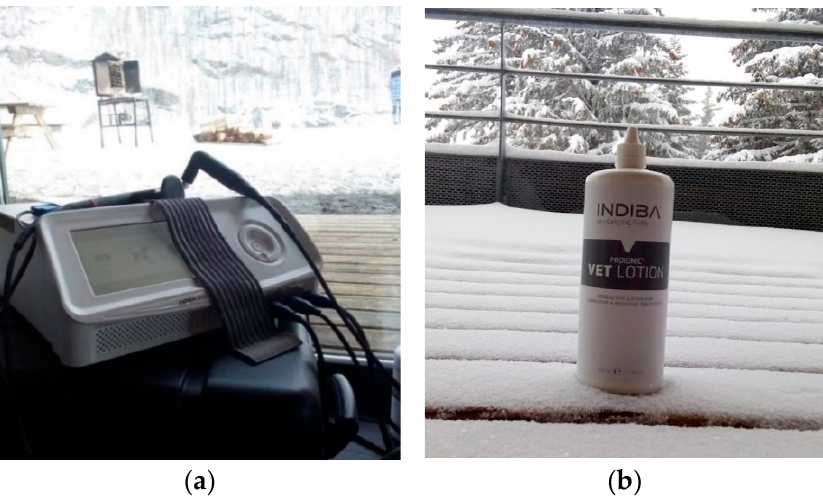
Figure 4. Material used for the application of CRet ( a ) shows the CRet device used during the study demonstrated good performance even in ambient temperatures below 0 °C; ( b ) the ionic lotion used was easily absorbed so that no special washing of the dogs was required after use.